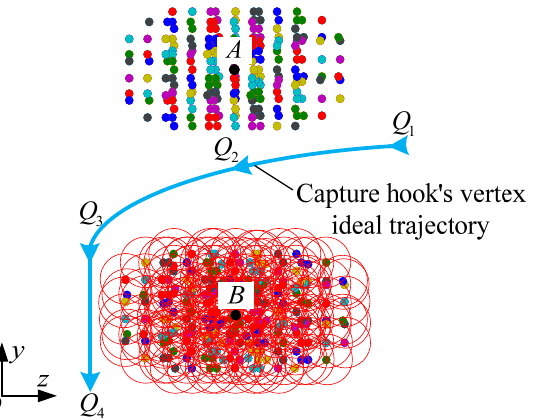
Figure 11. Schematic diagram of the ideal active end feature point trajectory. ( A : The top plate center of capture frame; B : The positioning shaft center of capture frame.)